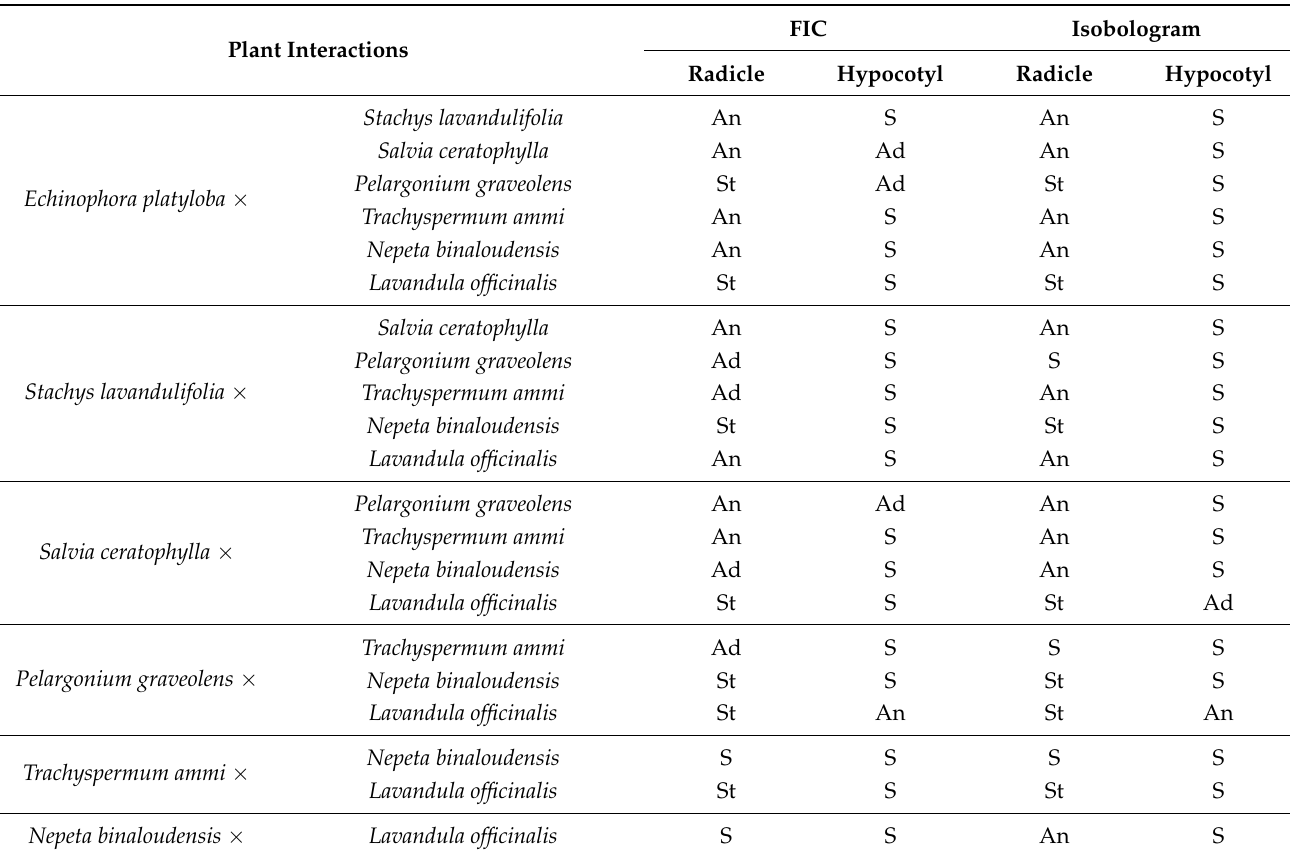
Table 5. Fractional Inhibitory Concentration (FIC) of combinations of the strongest inhibitory plants using EC 25 of lettuce radicle and